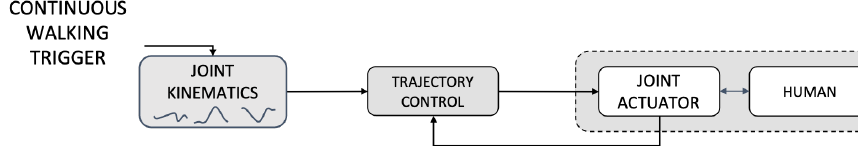
Figure 1. Conceptual diagram of the Exo-H3 trajectory control.